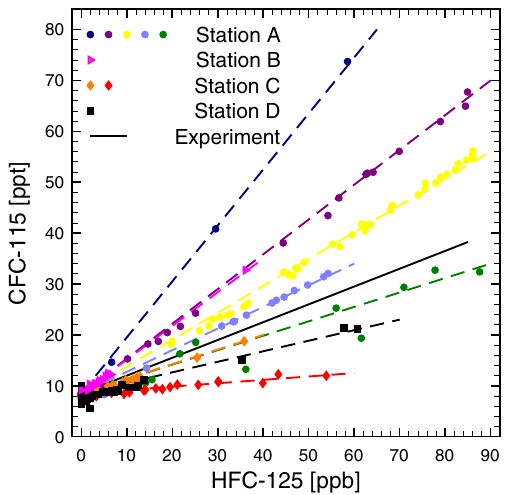
Figure 10. CFC-115 contamination in HFC-125 as found in con- taminated laboratory air samples at AGAGE stations. Measure- ments are shown for four stations (A–D) during times of air con- ditioner leakages (R-410, 50–55% by mass HFC-125, rest is HFC- 32). They are plotted for a HFC-125 range of 0–90ppb (parts per billion, 10 − 9 ). Differently colored episodes are separated by times of air conditioner maintenance and refilling, demonstrating the vari- able fraction of CFC-115 in differing batches of the refrigerant. Based on these observations we find a range from 0.7 × 10 − 4 mol to 11 × 10 − 4 mol CFC-115/mol HFC-125. The solid line (3 . 5 × 10 − 4 mol CFC-115/mol HFC-125) is the result from a direct mea- surement of CFC-115 in a dilution of an independently obtained sample of pure HFC-125. Dashed lines are approximated only and serve as visual support of the